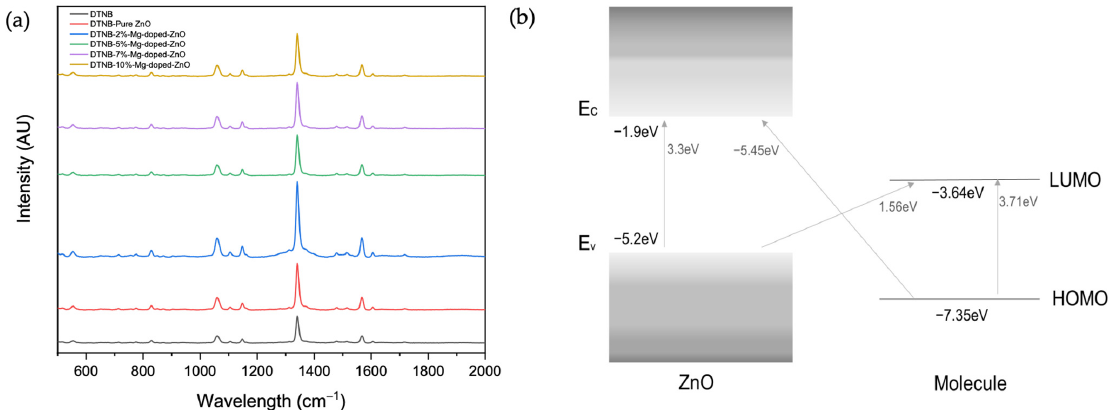
Figure 4. ( a ) Raman spectra of 10 − 2 M DTNB enhanced by ZnO and Mg-doped ZnO SERS substrates; ( b ) schematic diagram of energy band alignment between ZnO and DTNB.